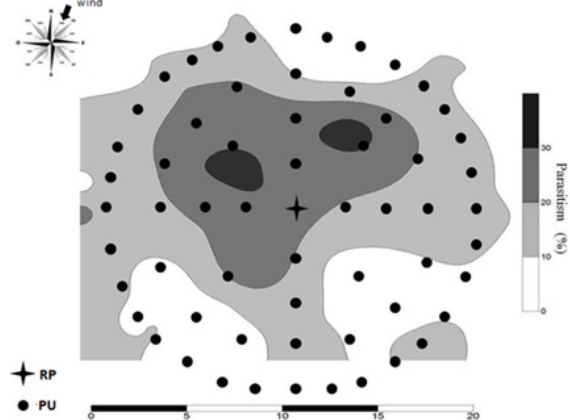
Figure 5. Spatial arrangement of parasitism units (PU), parasitoid release point (RP), wind direction (NE and 2.2 m/s) and interpolation of Trichogramma pretiosum (Hymenoptera: Trichogrammatidae) parasitism on eggs of Anagasta kuehniella (Lepidoptera: Pyralidae) in maize in the V4